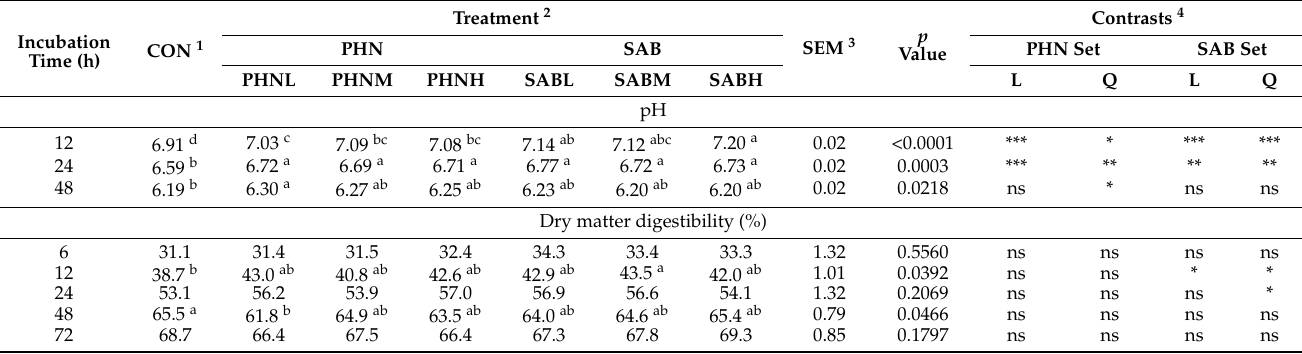
Table 4. Effects of bamboo leaves on pH and dry matter digestibility in in vitro